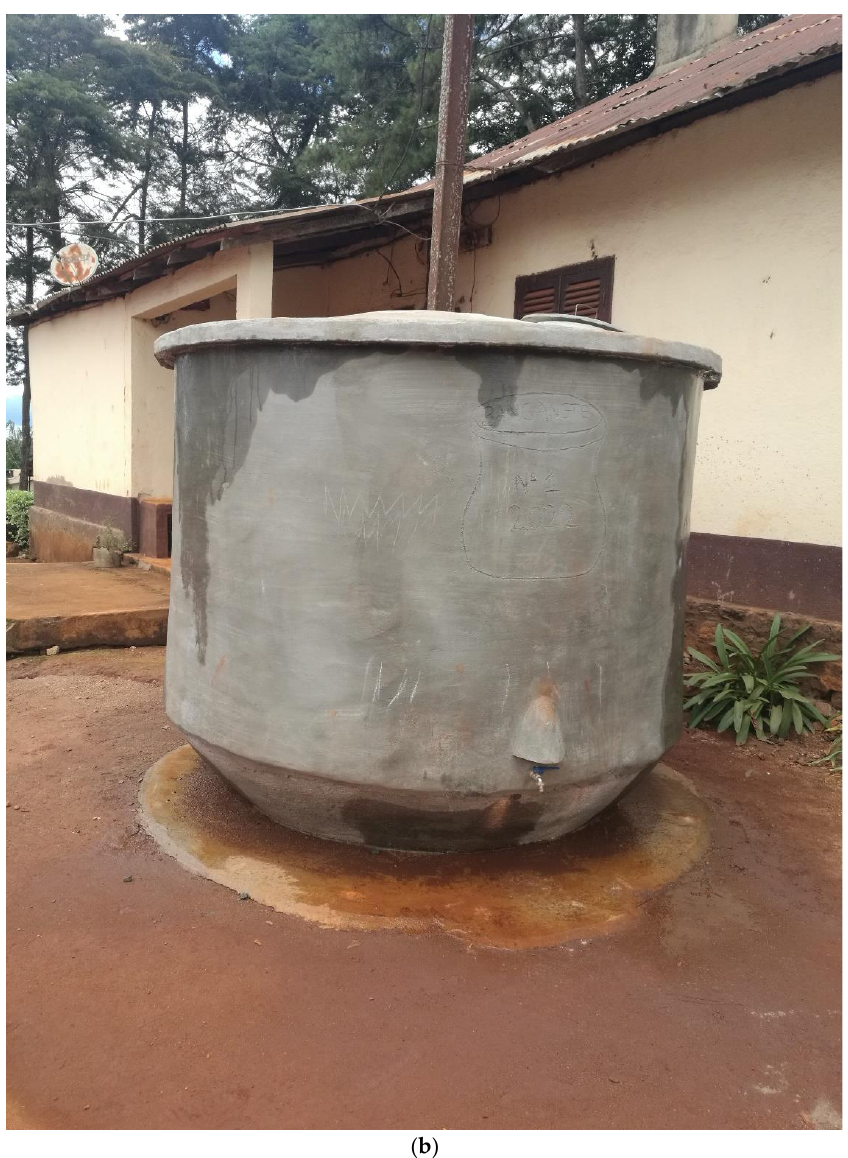
Figure 12. Photographs of two 5000 L tanks: ( a ) a commercial plastic tank and ( b ) an Akkerman Calabash.